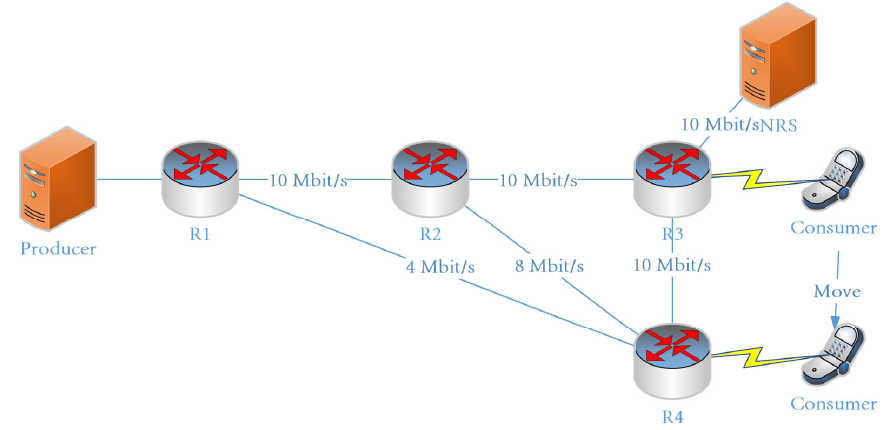
Figure 3. Simulation topology. Table 2. Experiment parameters and